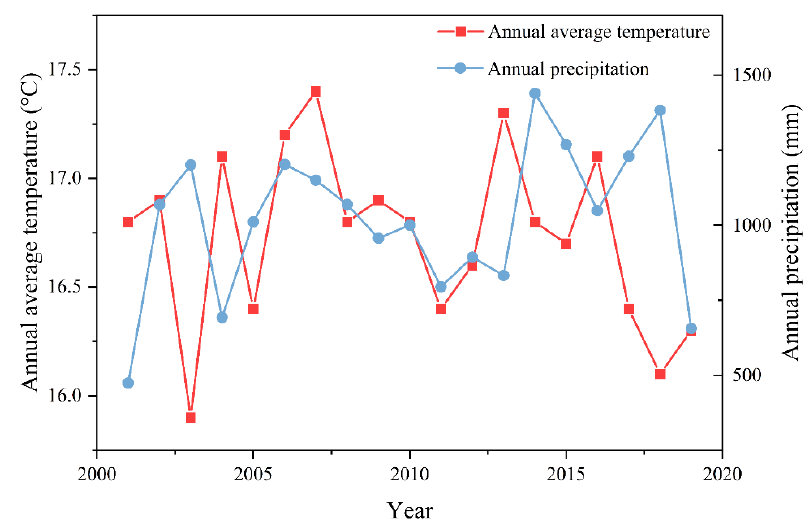
Figure 3. Precipitation and temperature changes from 2001 to 2019. Table 6. Pearson correlation coefficient table. Climate